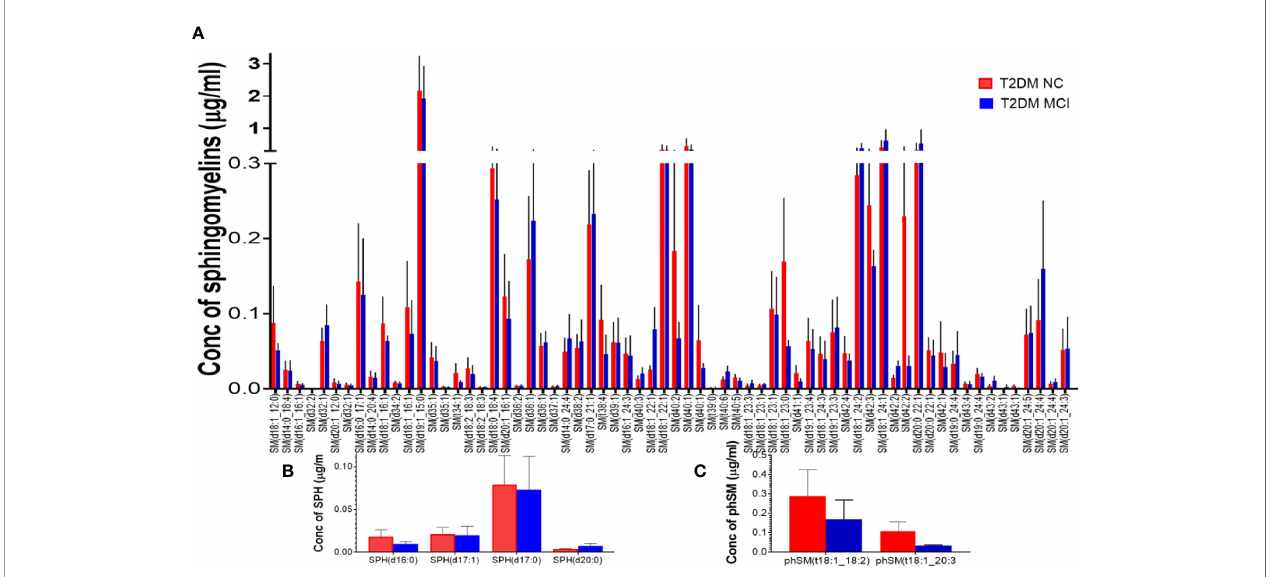
FIGURE 7 | A detailed evaluation of the individual species of sphingomyelins (SM), sphingosine (SPH), and phytosphingomelins (phSM) species in patients with MCI compared to the NC group of T2DM patients. Among 66 SM species evaluated in the targeted lipidomics, none of the species showed signi fi cant variations between the two studied groups (A) . Similarly, analysis of 4 SPH species (B) and 2 phSM species (C) demonstrated no signi fi cant difference between the two